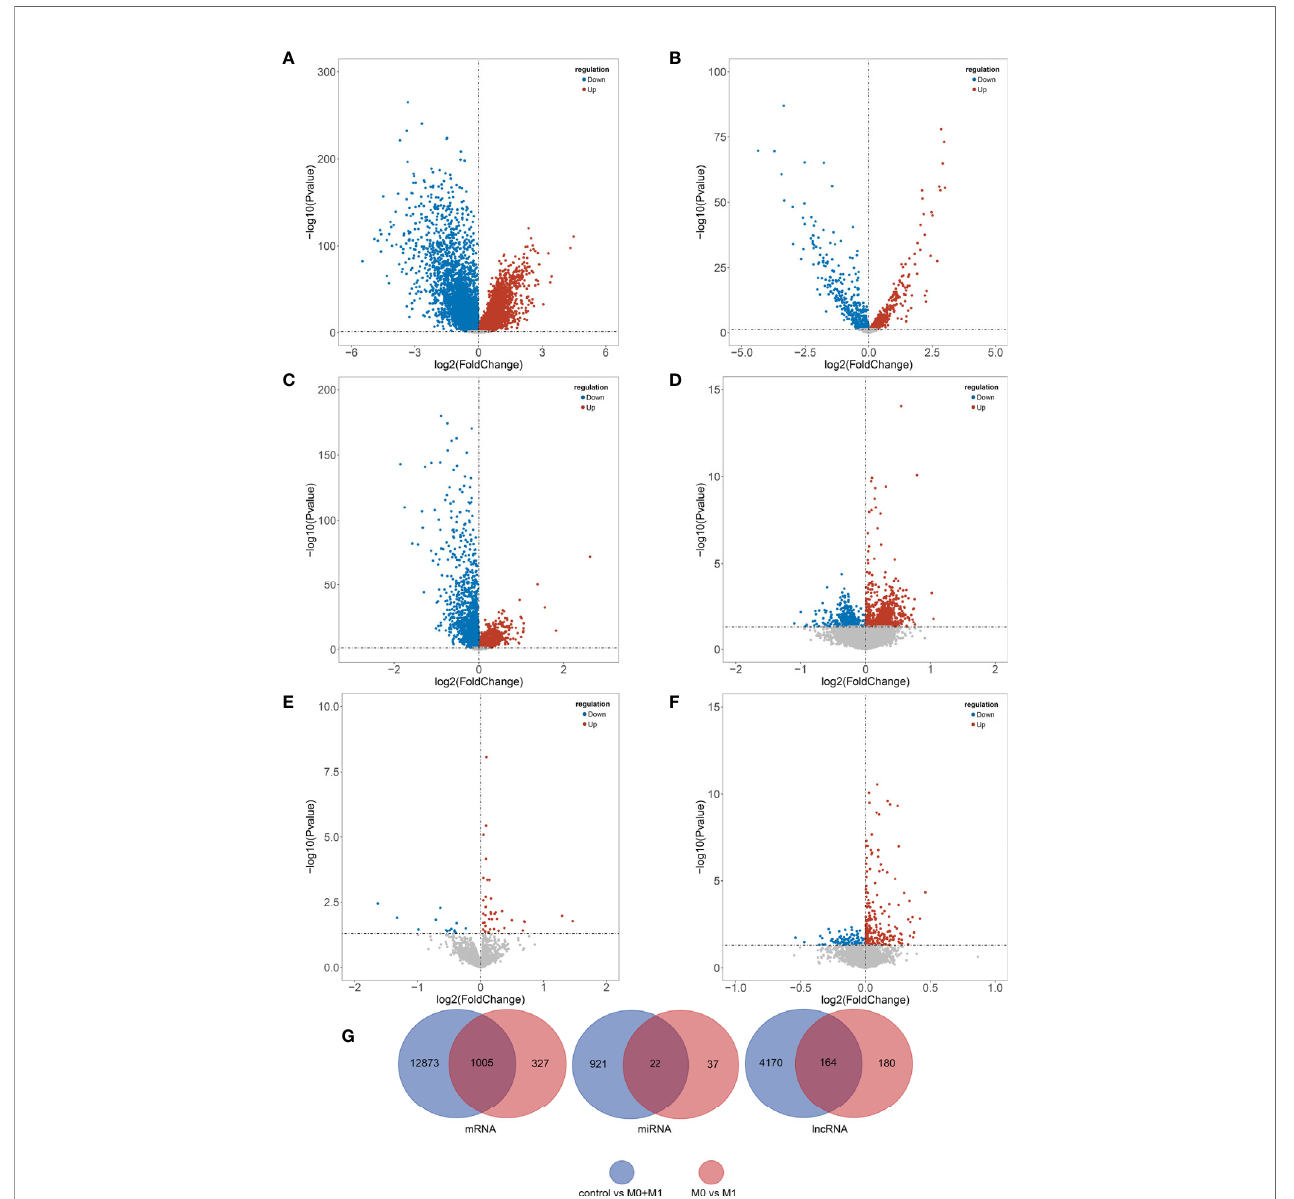
FIGURE 1 | Identi fi cation of differentially expressed and metastasis associated RNAs. DEmRNAs (A) , DEmiRNAs (B) , and DElncRNAs (C) between breast cancer patients and noncancerous tissue samples and MAmRNAs (D) , MAmiRNAs (E) , and MAlncRNAs (F) between M0 and M1 samples were presented using volcano plots. Venn diagram showing the overlapped the DERs and MARs (G) . Blue, downregulated; red, upregulated; black, not differential expressed. DEmRNAs, differentially expressed mRNAs; DEmiRNAs, differentially expressed miRNAs; DElncRNAs, differentially expressed lncRNAs; MAmRNAs, metastasis associated mRNAs; MAmiRNAs, metastasis associated miRNAs; MAlncRNAs, metastasis associated